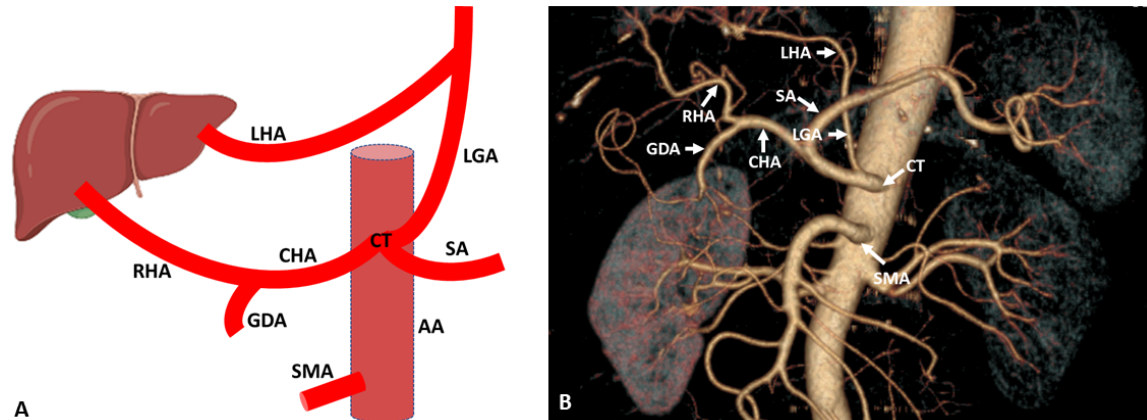
Figure 5. ( A ) Schematic representation of aberrant (replaced) LHA originated from LGA. ( B ) Three-dimensional (3D)-VR image (64 row CT-angiography) of the abdominal region showing aberrant (replaced) LHA originated from LGA. AA: Abdominal aorta; CT: Celiac trunk; SA: Splenic artery; LGA: Left gastric artery; CHA: Common hepatic artery; RHA: Right hepatic artery; LHA: Left hepatic artery; GDA: Gastroduodenal artery; SMA: Superior mesenteric artery.